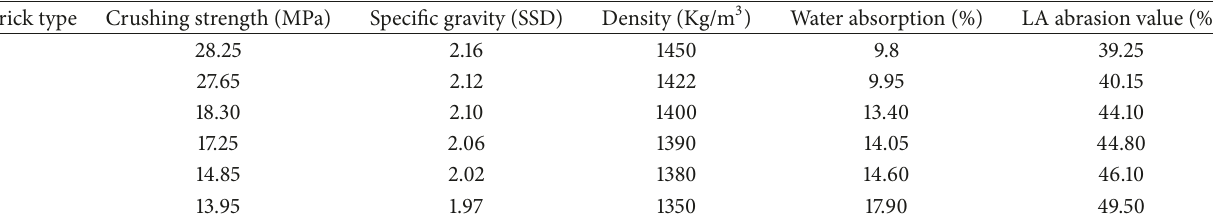
Table 1: Properties of brick and brick